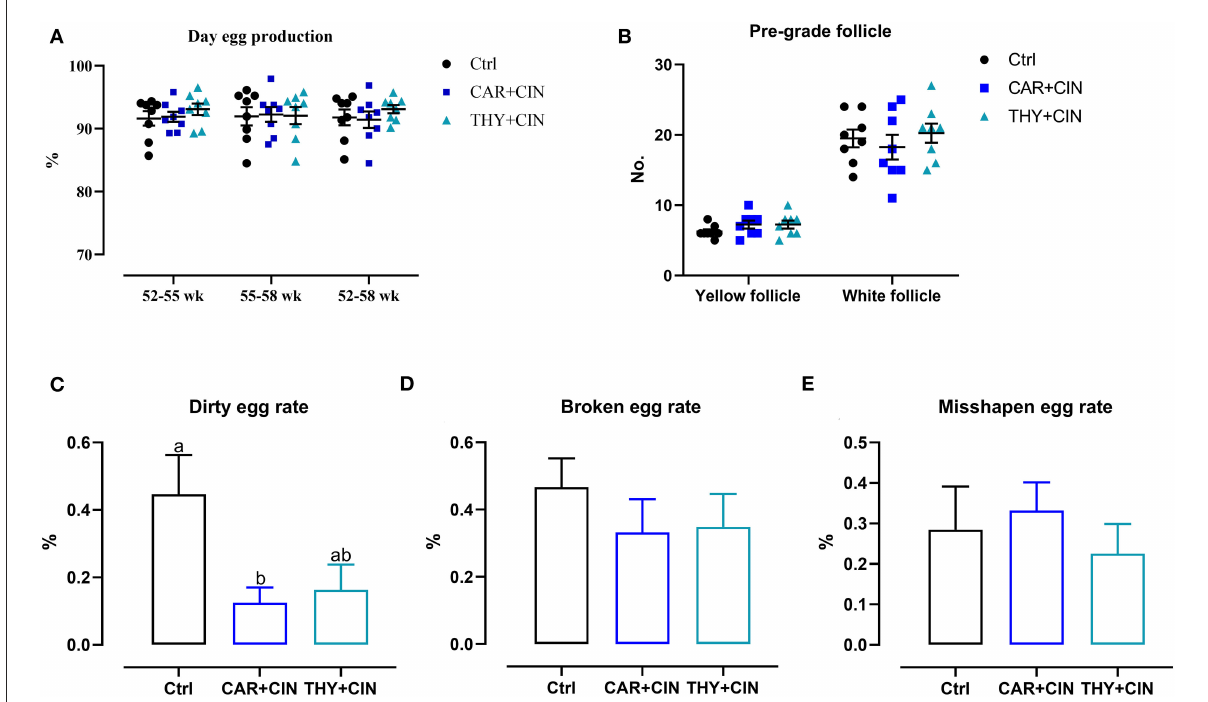
FIGURE1 The effects of dietary cinnamaldehyde with carvacrol (CAR + CIN) or thymol (THY + CIN) essential oils on (A) day egg production. (B) Number of the pre-grade follicle. (C) Dirty egg rate. (D) Broken egg rate. (E) Misshapen egg rate of post-peak laying hens. Means without common letter are significantly different ( P < 0.05, n = 8). Yellow follicles were pre-grade yellow follicles in the range of 6 - 12mm in size in the ovary; white follicles were pre-grade white follicles in the range of 1–6mm in size in the ovary. Dirty eggs, broken eggs, and misshapen eggs percentage were calculated as a percentage of the total number of eggs per week. In this study, a total of 384, 50-week-old Hy-line brown laying hens were randomly divided into a basal diet (Ctrl), a basal diet with 100 mg/kg of essential oils consisting of 4.5% cinnamaldehyde with 13.5% of carvacrol (CAR + CIN), and a basal diet containing 100 mg/kg of essential oils composed of 4.5% of cinnamaldehyde with 13.5% of thymol (THY + CIN) for 6